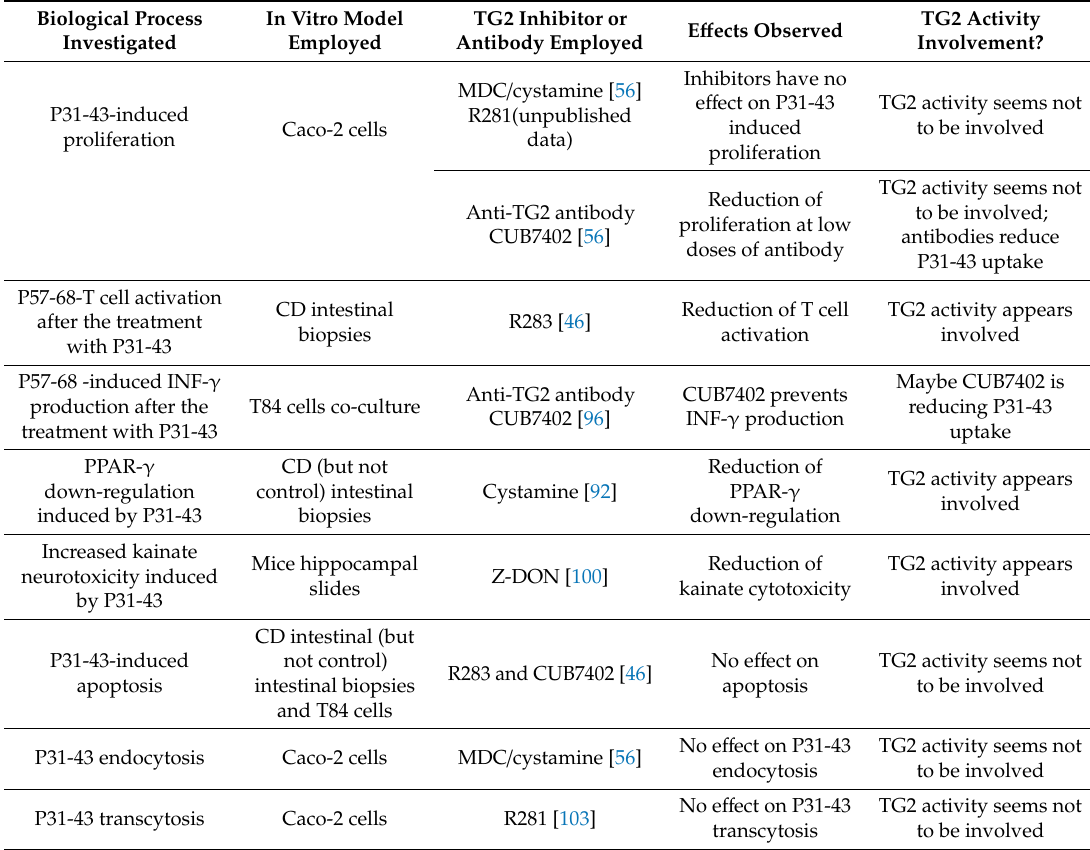
Table 1. Influence of TG2 inhibitors and anti-TG2 antibodies on the biological responses induced by P31-43 and on P31-43